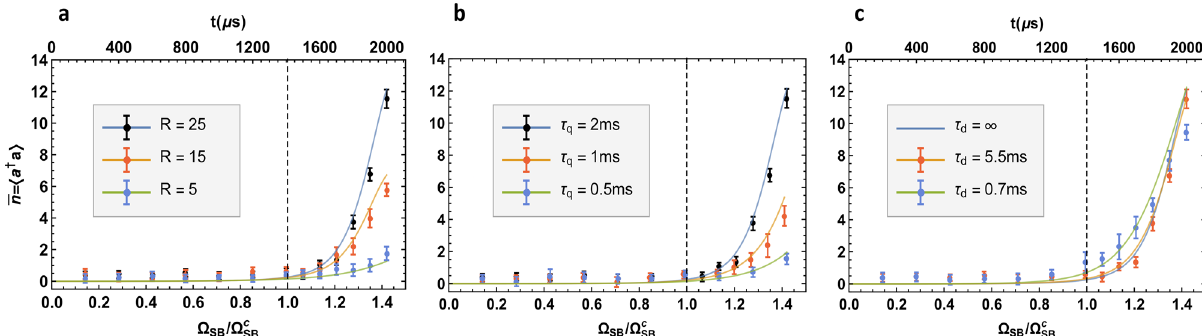
Fig. 4 Average phonon number versus sideband Rabi frequency under different experimental parameters. Each dot is an average phonon number measured in the same way as in Fig. 3, with the error bar representing one standard deviation. In a – c , we vary the ratio parameter R , the total quench time τ τ Ω c ¼ 2 π ´ 10 kHz and q and the motional decoherence time d , respectively, while keeping the other parameters the same as those in Fig. 3. a . We keep SB τ = 2 ms. Then we need δ = 2 π × 41.3 kHz and δ = 2 π × 36.1 kHz for R = 15 and δ = 2 π × 26.8 kHz and δ = 2 π × 17.9 kHz for R = 5. b We keep q b r b r Ω c ¼ 2 π ´ 10 kHz, R = 25, but use different quench time τ Ω c ¼ 2 π ´ 10 kHz, R = 25 and τ = 2 ms, but vary the motional decoherence time q . c We keep q SB SB τ τ = 5.5 ms) or off ( τ = 0.7 ms) the locking of the experimental sequence to the 50 Hz reference. The curves in a and b are from d by turning on ( d d numerical simulation without considering the motional decoherence, similar to the τ d = ∞ curve in c . The other two curves in c include the motional decoherence effect by numerically solving a Lindblad master equation (see “ Methods ” section for more details). The difference between τ d = ∞ and τ d = 5.5 ms is very small for the quench time τ q = 2 ms, thus justi fi es our simpli fi cation of τ d = ∞ for a , b and the previous numerical